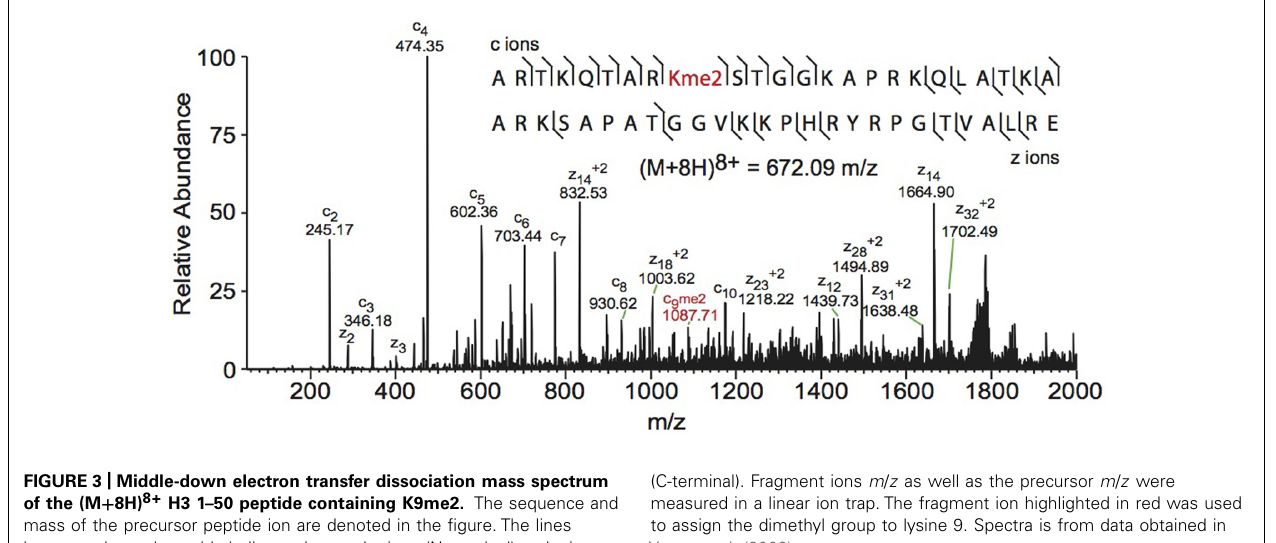
FIGURE 3 | Middle-down electron transfer dissociation mass spectrum of the (M + 8H) 8+ H3 1–50 peptide containing K9me2. The sequence and mass of the precursor peptide ion are denoted in the figure. The lines between the amino acids indicate observed c ions (N-terminal) and z ions